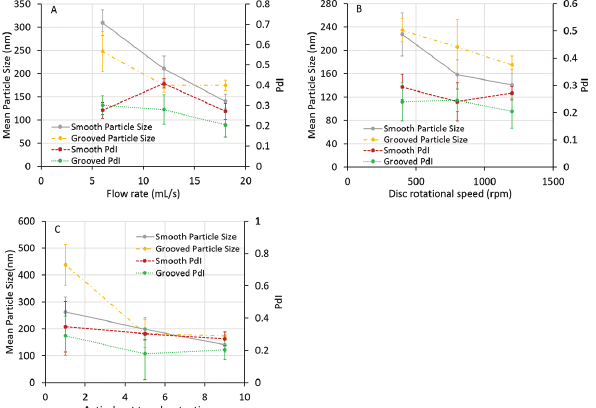
Figure 12: Comparison between smooth and grooved disc for the effect of (a) flow rate (1200 rpm, 9:1 ratio), (b) disc rotational speed (18 mL/s, 9:1 ratio), (c) antisolvent to solvent ratio (1200 rpm, 18 mL/s).